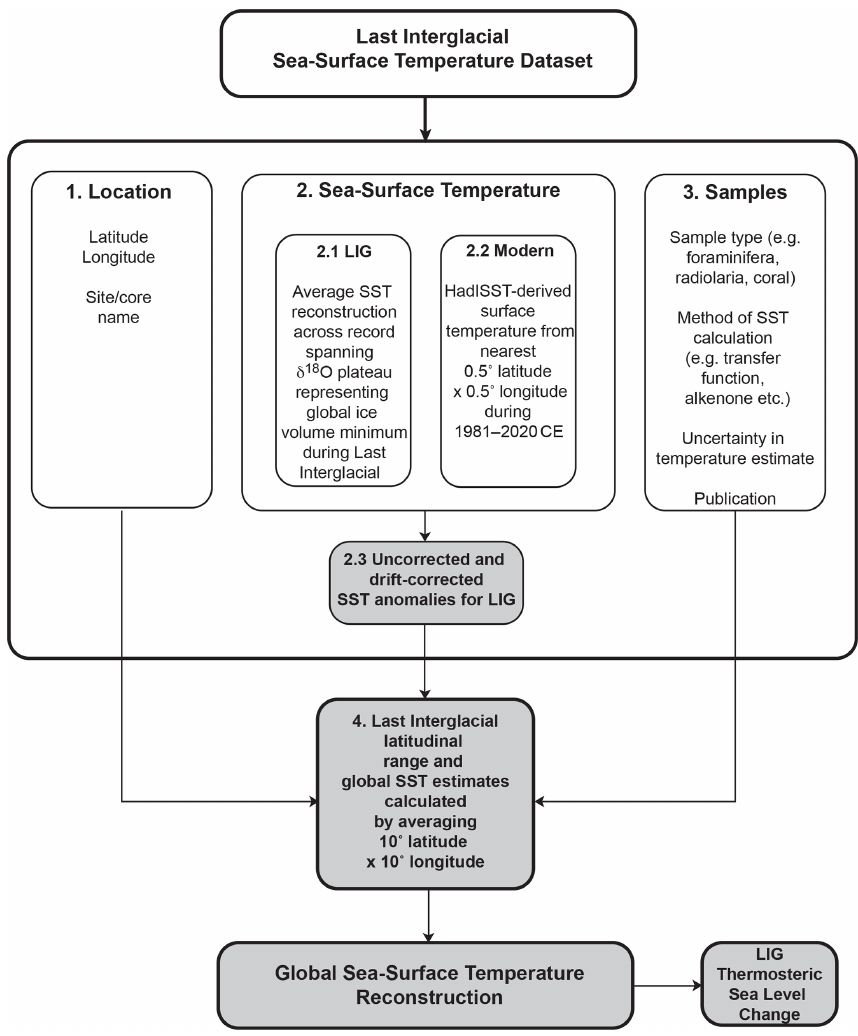
Figure 3. Simplified scheme for the generation of the Last Interglacial (LIG) sea surface temperature (SST) database providing an overview of the data collection and processing. The numbered boxes set out the stages required to generate a global database of surface temperatures from marine records: (1) location, (2) Last Interglacial and modern SSTs (including drift calculation), and (3) metadata, including method of temperature reconstruction and associated uncertainty. Grey boxes indicate additional processing of data from the original publications, generating new outputs (which are provided in the